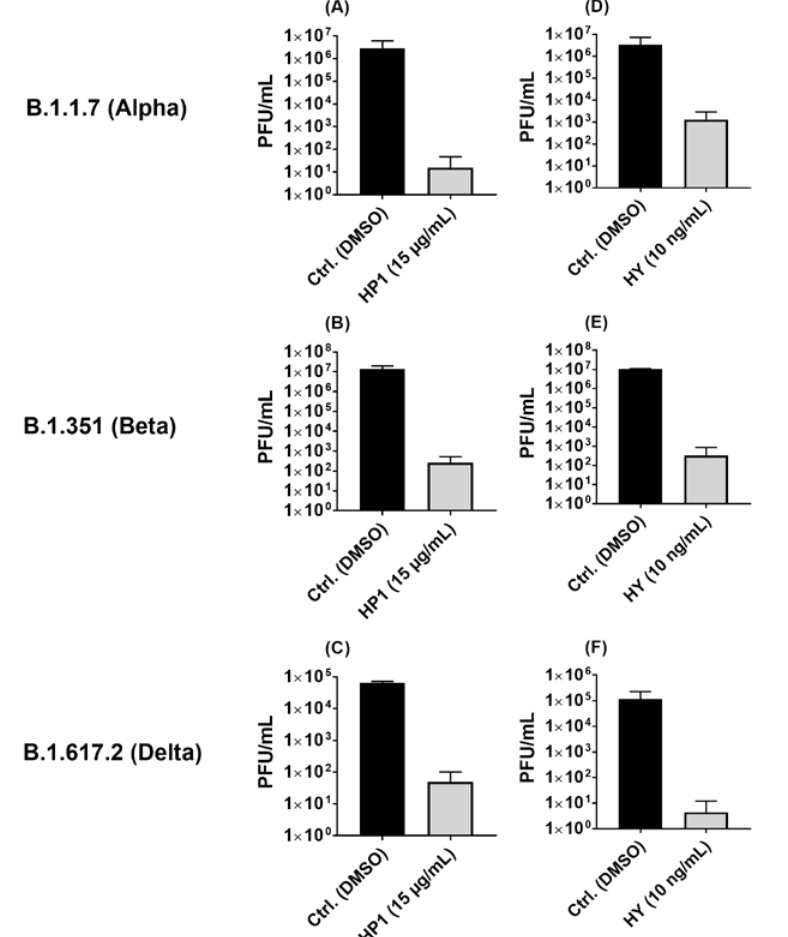
Figure 5. Hypericum perforatum (HP1) and hypericin (HY) inhibit the growth of different SARS-CoV-2 variants. ( A – F ) Vero cells were seeded overnight, and the next day, before being infected, cells were incubated in infection-DMEM containing solvent control (DMSO) or either ( A – C ) HP1 or ( D – F ) hypericin for 1h, at 37 ◦ C. Meanwhile, SARS-CoV-2 variants were also preincubated (1 h at room temperature) before infection in infection-PBS with either solvent control or ( A – C ) HP1 or ( D – F ) hypericin. After pre-incubation, virus infection was performed at a MOI of 0.05 for 1 h. After infection, cells were either incubated with solvent control or ( A – C ) HP1 or ( D – F ) hypericin. After 24 h infection, virus supernatants were collected, and virus titration was done by plaque assays. ( A – F ) Obtained data are shown as PFU/mL (mean and s.d.).